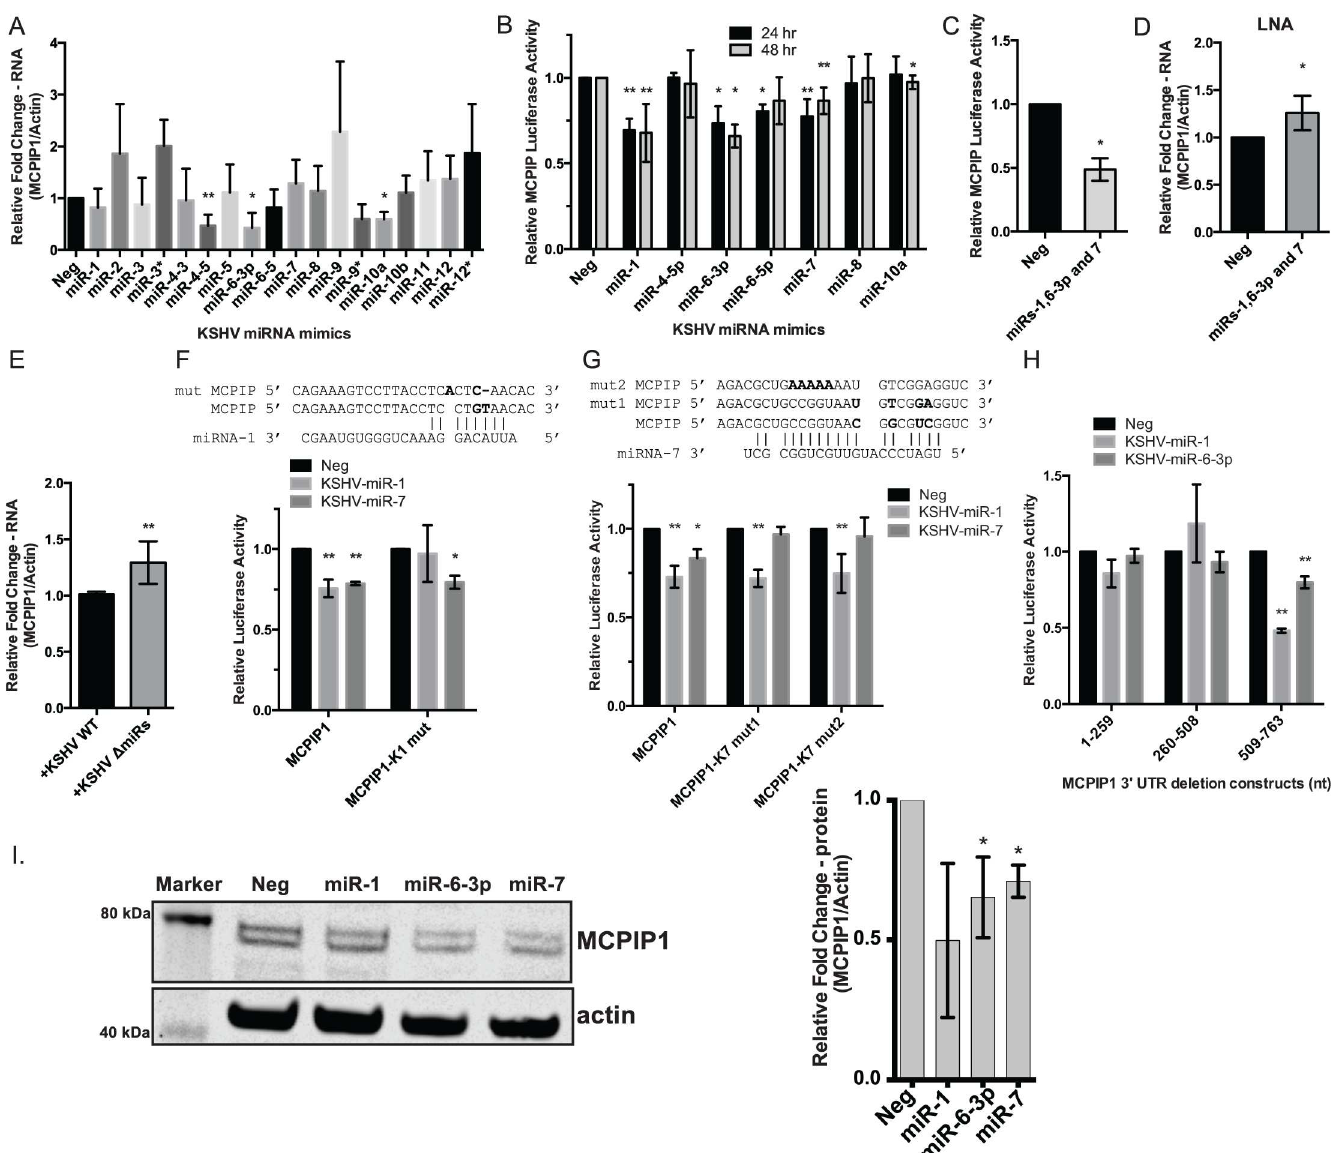
Fig 4. KSHV miRNAs target the MCPIP1 3’ UTR. (A) MCPIP1 RNA expression was determinedusing qPCR from HUVECs transfected with individual KSHV miRNA mimics. Results are shown relativeto β -actin and normalized to the negativecontrol, N = 2–7. (B) 293 cells were transfected with individual KSHV miRNAs and a MCPIP1 3’ UTR reporter plasmid. Lysates were analyzed24 or 48 hpt, and relative MCPIP1 luciferase activity is expressedas a ratio to an internalluciferase control and normalizedto an empty reporter vector and the negative control miRNA, N = 3–9. (C) 293 cells were transfected with